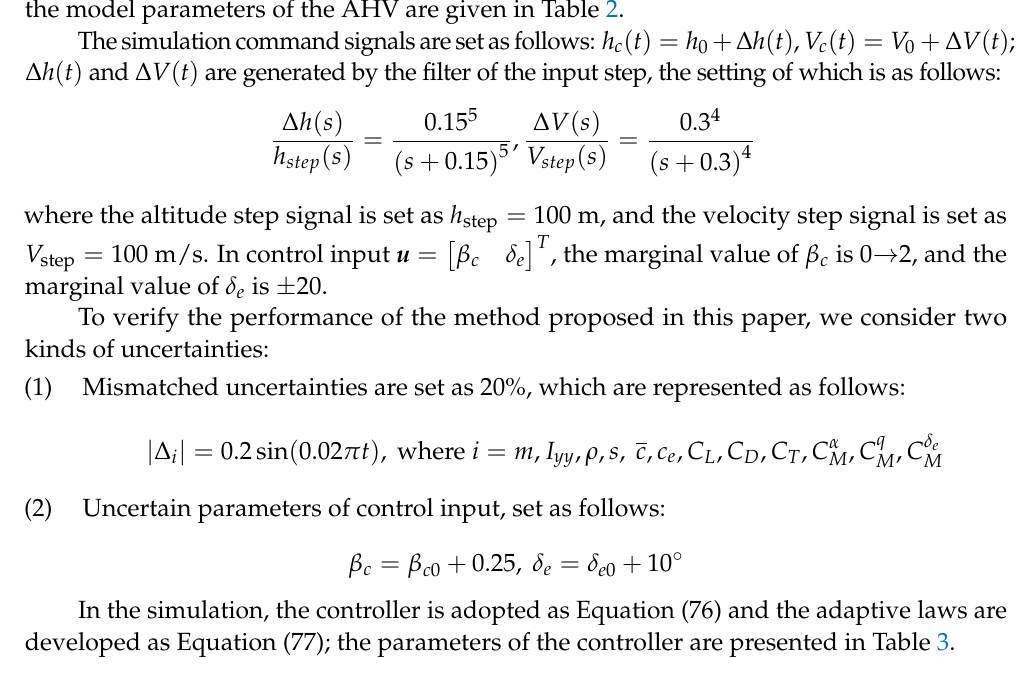
Table 3. Parameters of controller.